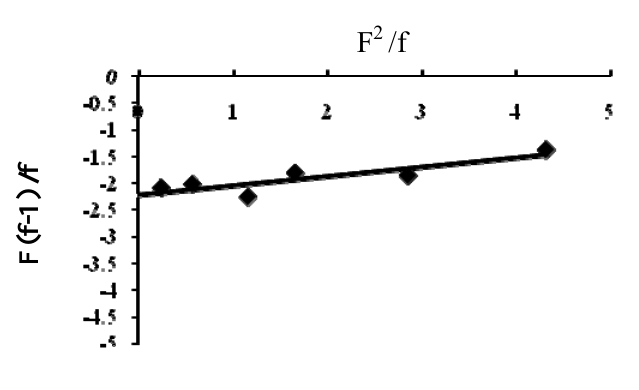
Figure 1. F(f-1)/f vs F 2 /f plot for Poly(DTBTC- co -VI) ( II